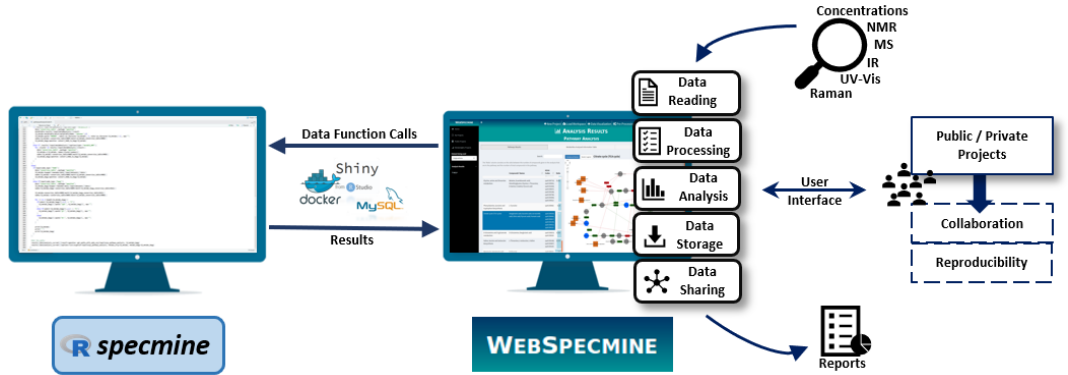
Figure 1. Global overview of WebSpecmine ’s features and their implementation using the specmine R package and the tools Shiny , MySQL and Docker